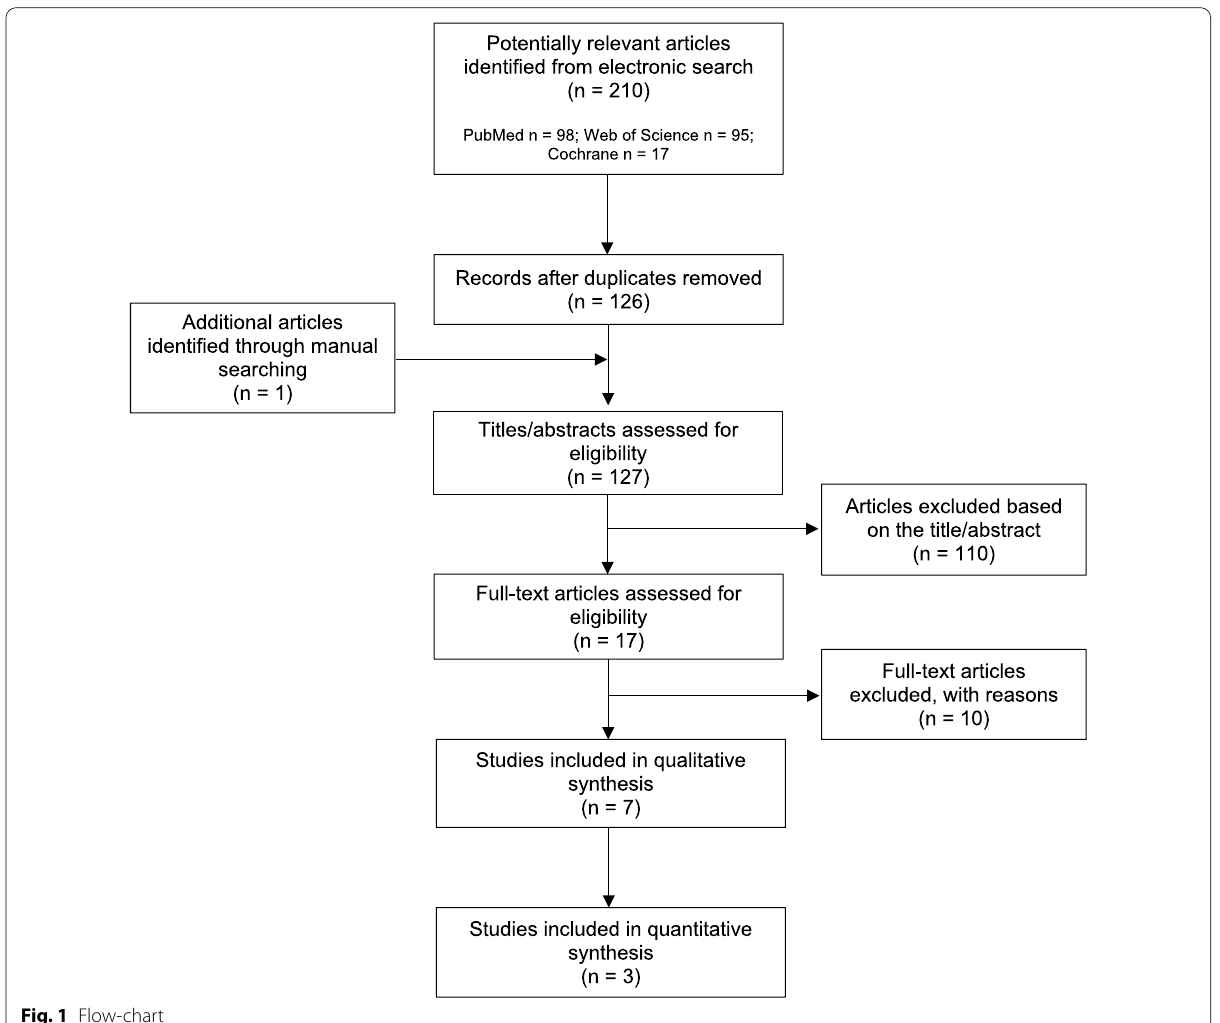
end of sinus augmentation, the bone window was fixed with cyanoacrylate-based surgical glue [29, 31] or mini- screws [18, 19]. In Moon et al., no fixation method was reported [17]. In all the included studies, bone healing was assessed through histological analysis and details are provided in Table 2. In four studies histomopho- metric evaluation was performed [17, 18, 29, 31], and in one immunohistochemical analysis was conducted [19]. New bone was found mainly originating from the sinus bone walls. In rabbit models, where euthanasia was performed at multiple times, new bone density and thickness were found to increase overtime. In the repositioned bone window sites, at the histo- logical analysis the bone lid appeared well integrated with the margin of the antrostomy, while